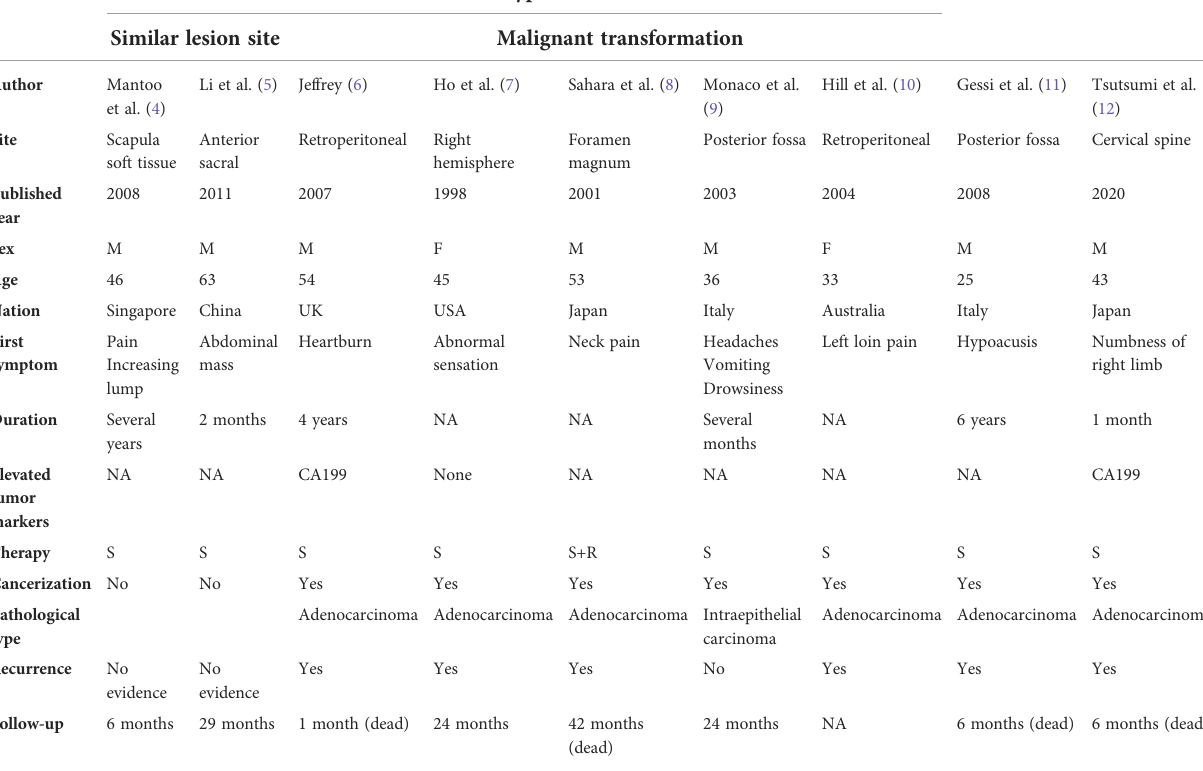
TABLE 1 Characteristics of cases with ECs from published